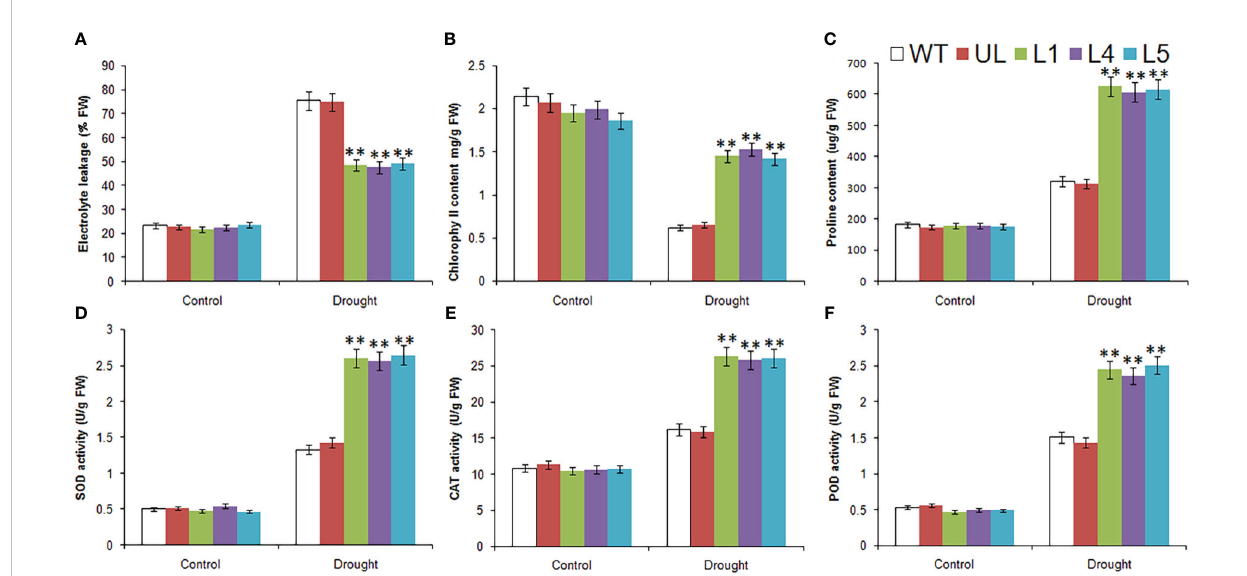
FIGURE 9 Physiological and biochemical indicatorsin MbMYBC1 -OE A. thaliana under drought stress. (A) EL, (B) Chlorophyll content, (C) proline content, (D) SOD activities, (E) CAT activities, and (F) POD activities. (**, P ≤ 0.01). The control was the index in the WT. All data were the average of 3 measurements.